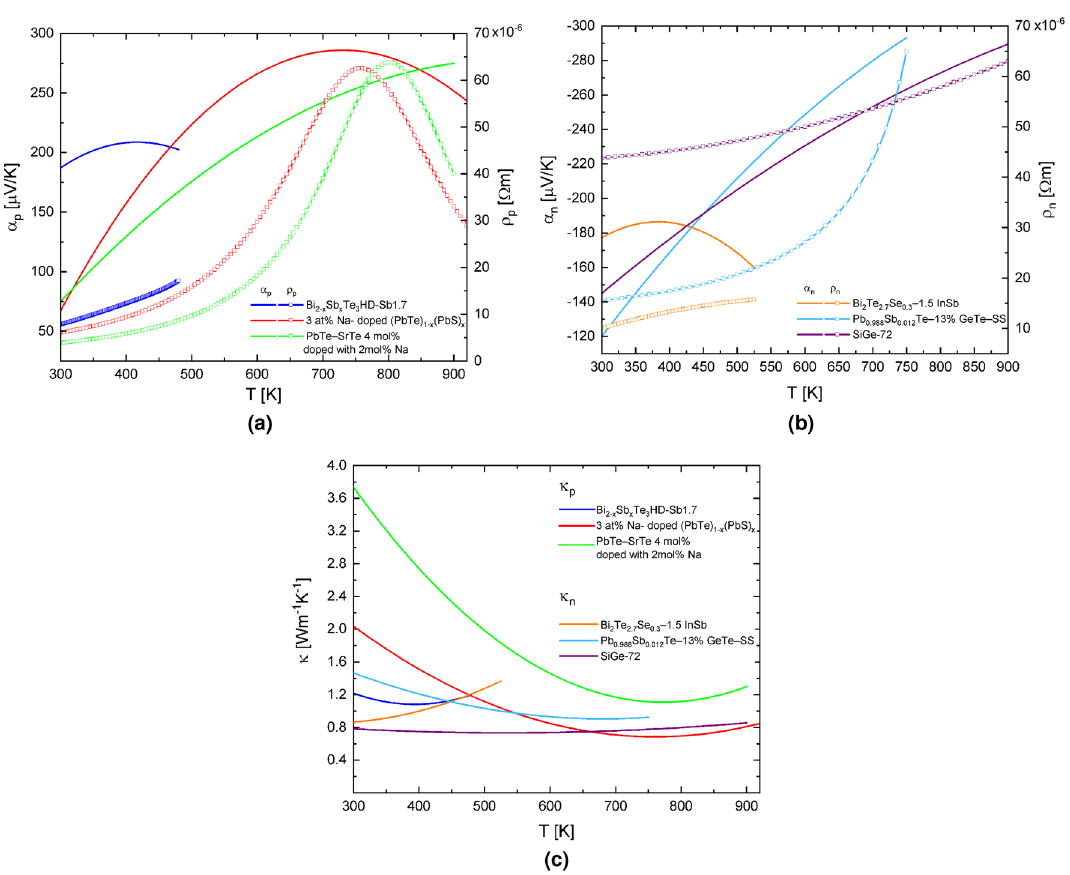
Figure 2. Temperature dependence of ( a ) Seebeck coefficient ( α p ) and resistivity ( ρ p ) of the p-type material, ( b ) Seebeck coefficient ( α n ) and resistivity ( ρ n ) of the n-type material and ( c ) Total thermal conductivity ( κ p , κ n ) for used TE